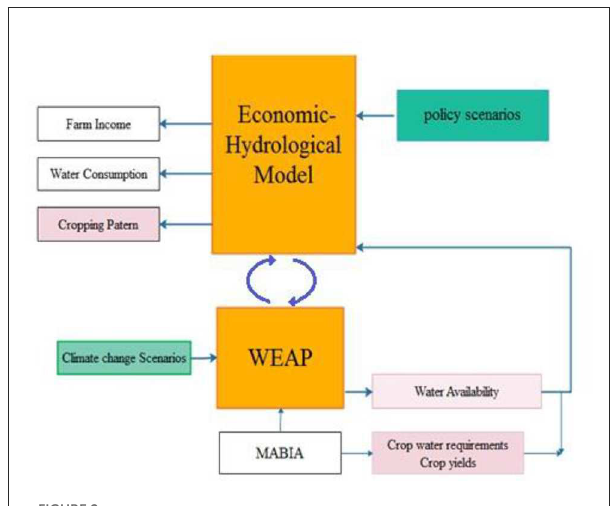
FIGURE2 The conceptual framework of the quantitative management model for the Zayanderud